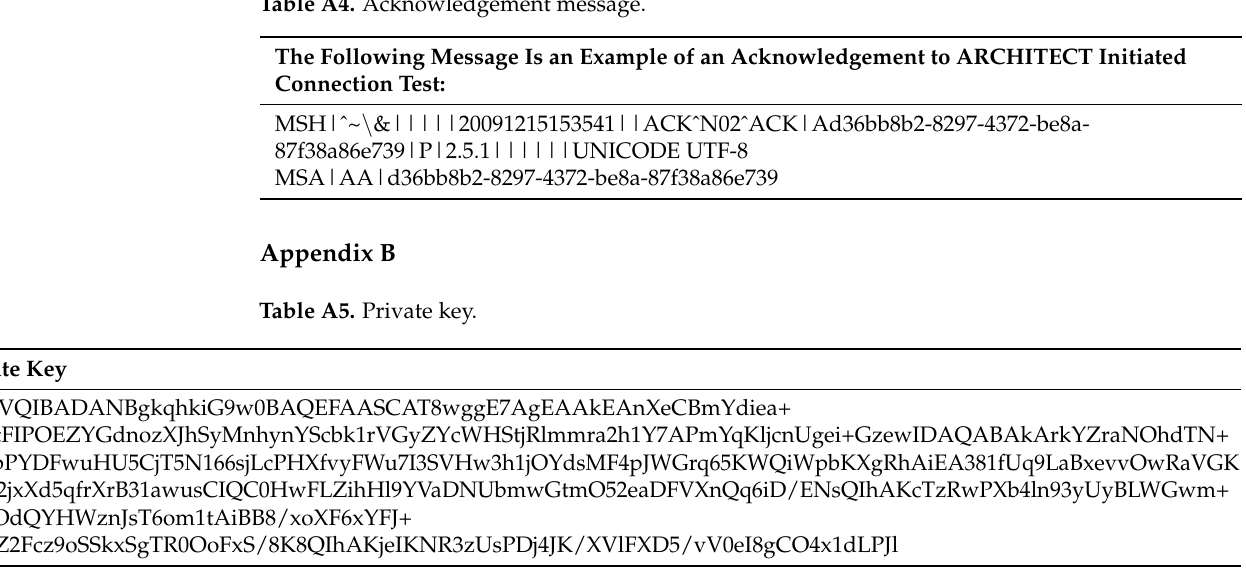
Table A4. Acknowledgement message.